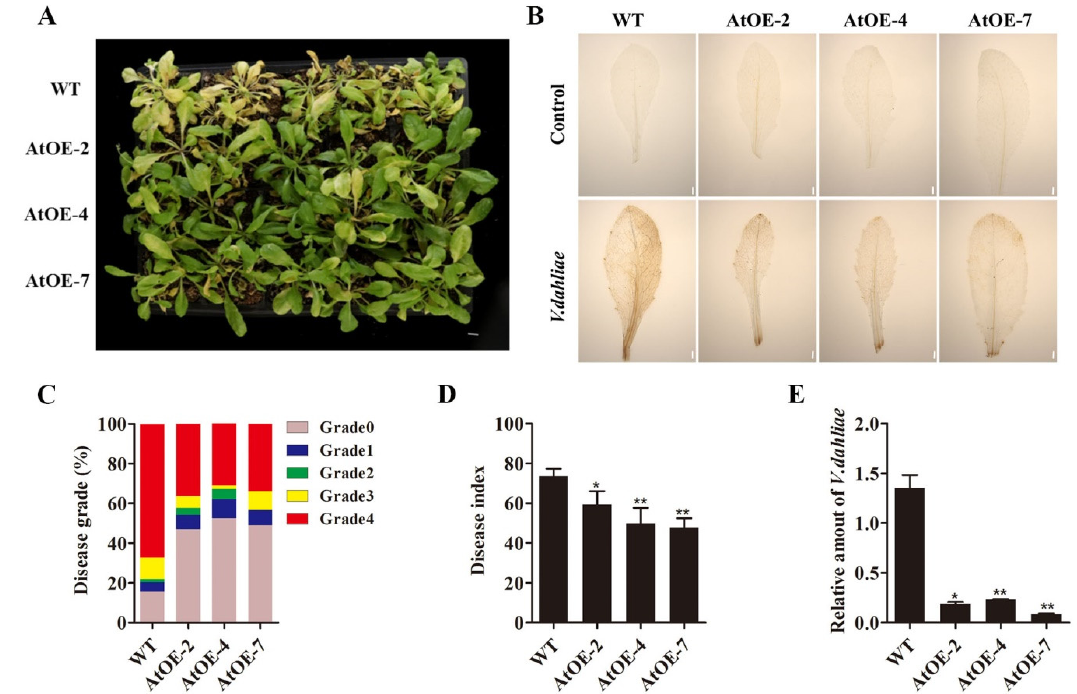
Figure 5. Ectopic expression of GhCYP710A1 gene in Arabidopsis with enhanced resistance to Verticillium dahliae . ( A ) Symptoms of Arabidopsis thaliana 10 days after Verticillium wilt infection. WT: wild-type Arabidopsis control; AtOE-2, AtOE-4, AtOE-7: transgenic Arabidopsis lines. Scale bar = 1 cm. ( B ) DAB staining of wild-type and transgenic Arabidopsis leaves after Verticillium dahliae infection for 10 days. The brown material reflects the hydrogen peroxide content. Scale bar = 1 mm. ( C ) Statistics of disease grade. ( D ) Statistics of disease index. The resistance of transgenic Arabidopsis was evaluated by disease index. ( E ) qRT-PCR was utilized to analyze fungal biomass in wild-type and transgenic Arabidopsis leaves after Verticillium dahliae infection for 10 days. DNA content of Verticillium dahliae internal transcribed spacer (ITS) was used as a fungal biomass standard; DNA levels of Arabidopsis actin were used as an internal reference. Error bars represent SD of three independent replicates. * represents p < 0.05, ** represents p < 0.01 .